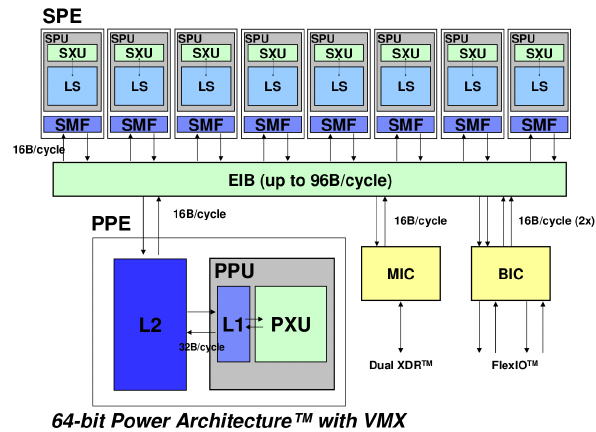
Fig. 2. Four instances of the array variable t , which extends over all layers of the column, are packed together into a single array of vectors. Fig. 3. The exchange of tasks between the top-level radiation func- tion and the threads in the thread pool through the task queue.